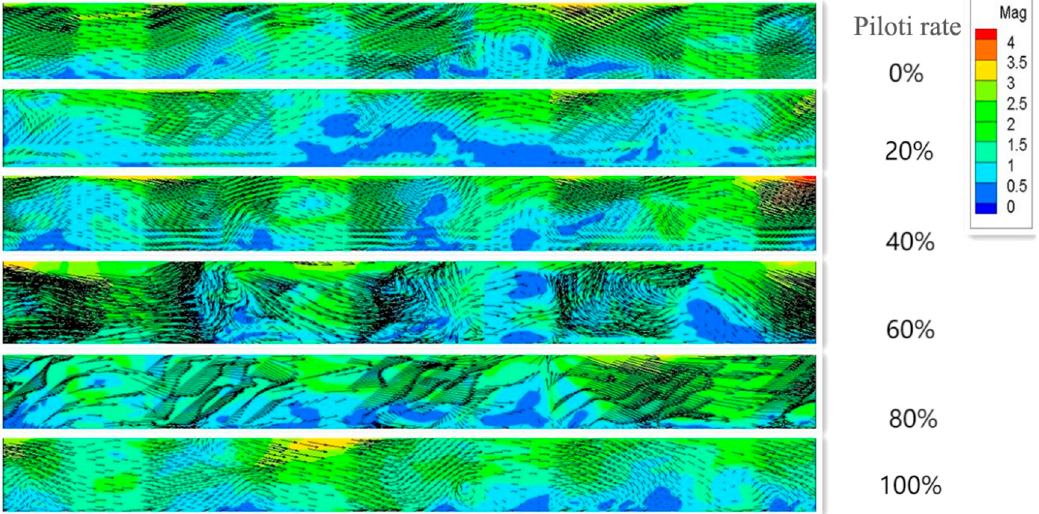
Figure 20. Vector diagram of the target area of Section 2 (Enclosed model).